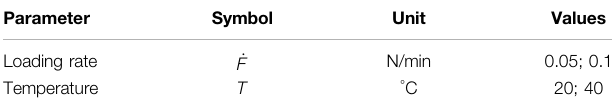
TABLE 3 | Transverse tensile modulus — test parameters.